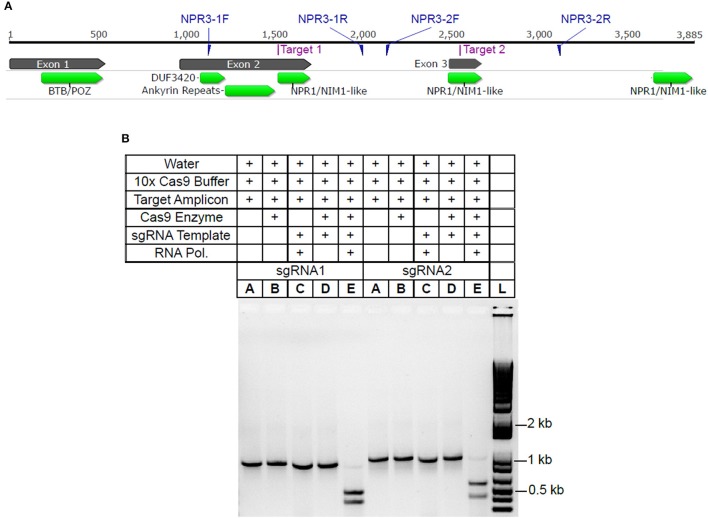
TcNPR3 gene model and demonstration of sgRNA activity in vitro
(A). TcNPR3 gene model based on the Criollo genome sequence. Numbers above the gene model indicate length in bp, starting at base 1 of the ATG start codon. Target sites for selected sgRNAs and primer binding sites for amplification of sgRNA target amplicons are indicated. Functional domains were predicted using CDSearch (Marchler-Bauer et al., 2015). (B) Agarose gel electrophoresis demonstrating activity of sgRNAs in in vitro assay of sgRNAs 1 and 2, corresponding to Target 1 and Target 2 in 1A. Table above gel indicates reagents and templates added to each reaction and loaded into each lane. sgRNA template and RNA polymerase indicates presence/absence in sgRNA synthesis reaction preceding Cas9 activity assay. Lane L was loaded with 1 KB Plus Ladder (NEB).